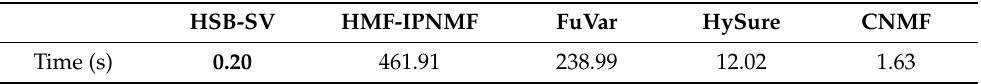
Table 9. Time processing for each method for the real dataset (in seconds).